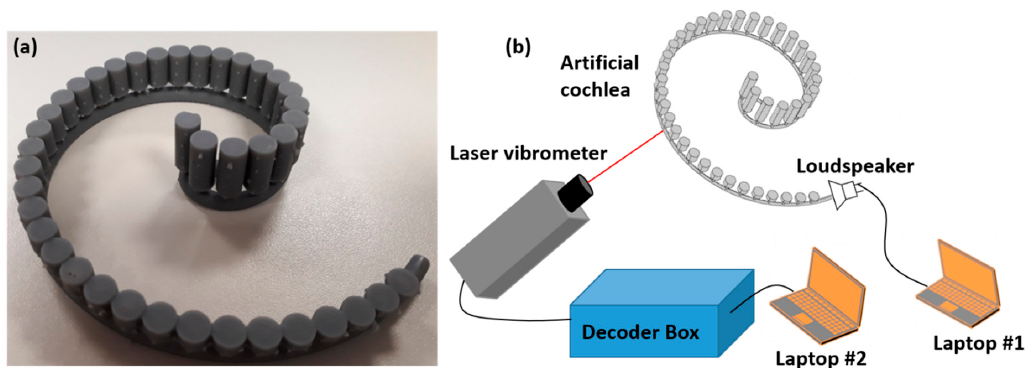
Figure 5. Experimental verification of artificial cochlea for acoustic wave trapping, ( a ) 3D printed spiral structure with Helmholtz resonators, ( b ) schematic of the experimental setup. A loudspeaker is connected to the opening of the spiral tube to generate acoustic waves. A point laser Doppler vibrometer was used to measure the acoustic waves at three different locations.